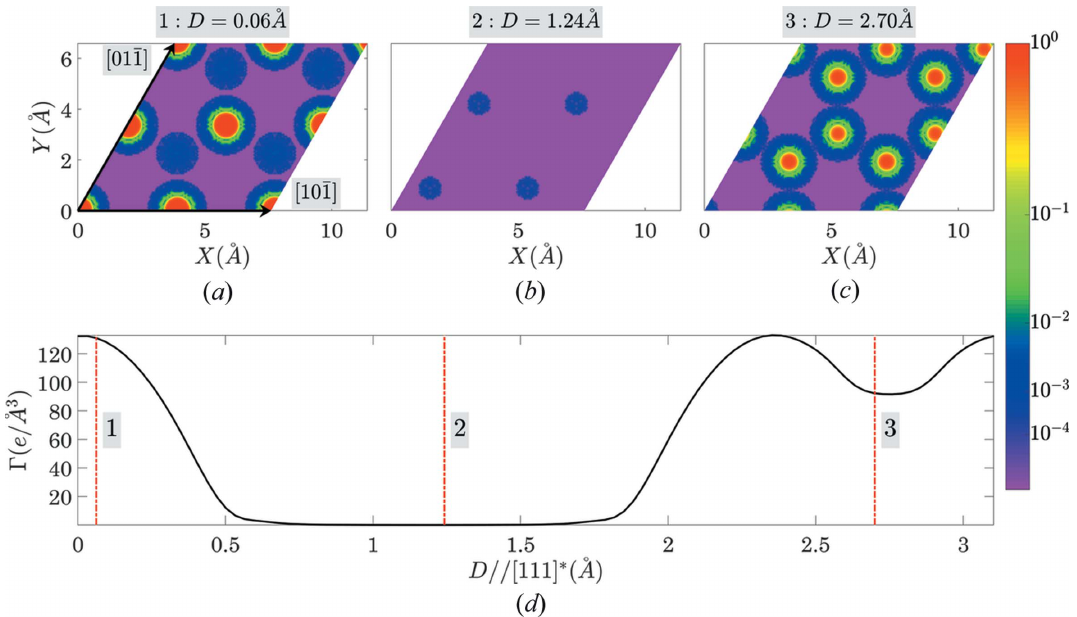
Figure 7 An illustration of the structural-gap location for the case of the (111) plane in silicon. The parts ( a )–( c ) show three electron-density sections by the (111) plane at three various positions of the plane in the unit cell, while ( d ) shows the (cid:2) (111, D ) function with the vertical lines at the positions corresponding to the electron-density sections in ( a )–( c ). Table 5 Magnitudes of C hkl in quartz.